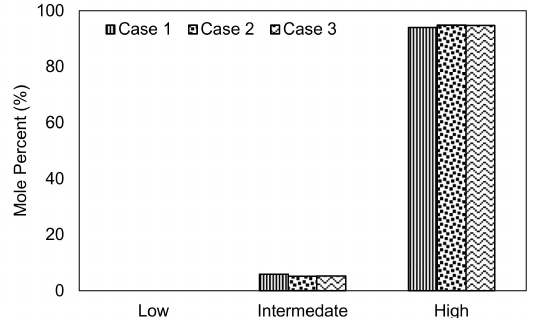
Figure 5. Remaining oil composition of CO 2 -ethanol mixture injection based on carbon number clas-